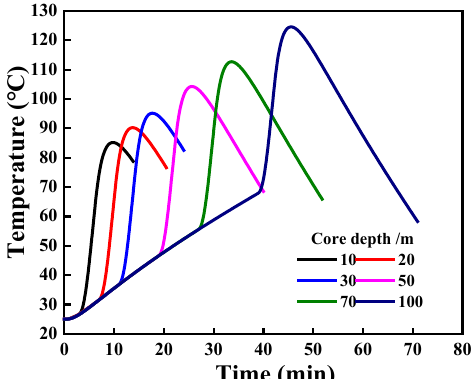
Figure 17. Temperature variation law of temperature measuring point at different core depths in GHS.